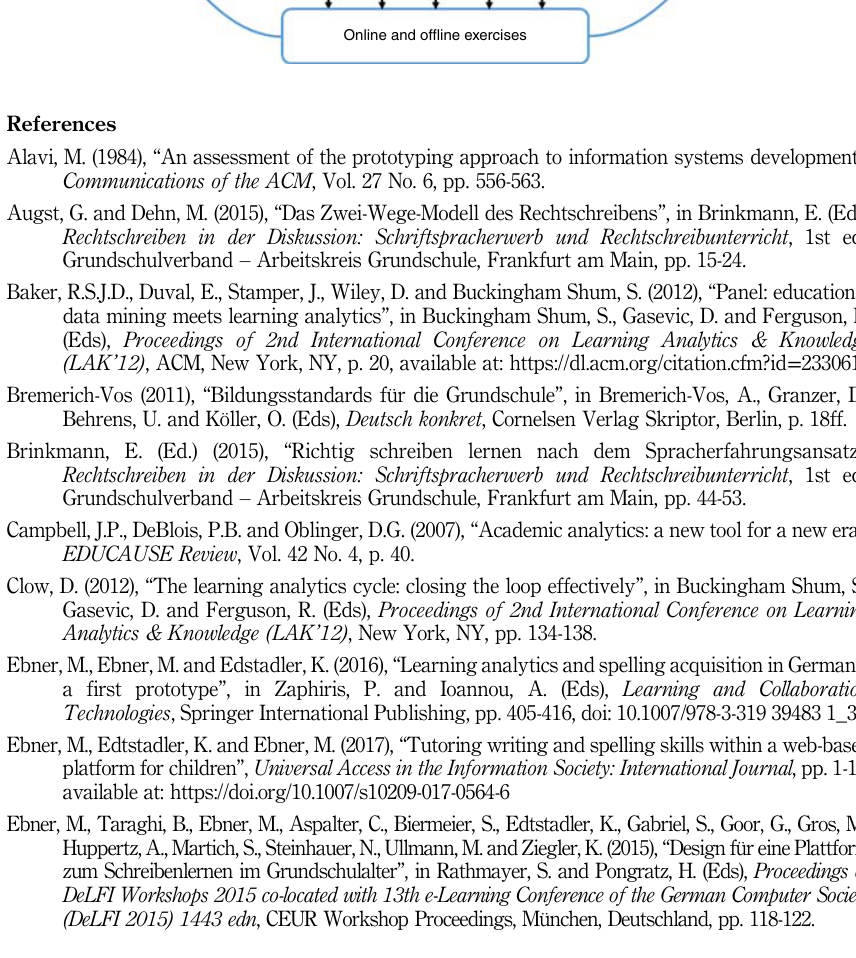
Figure 10. The holistic approach with LA